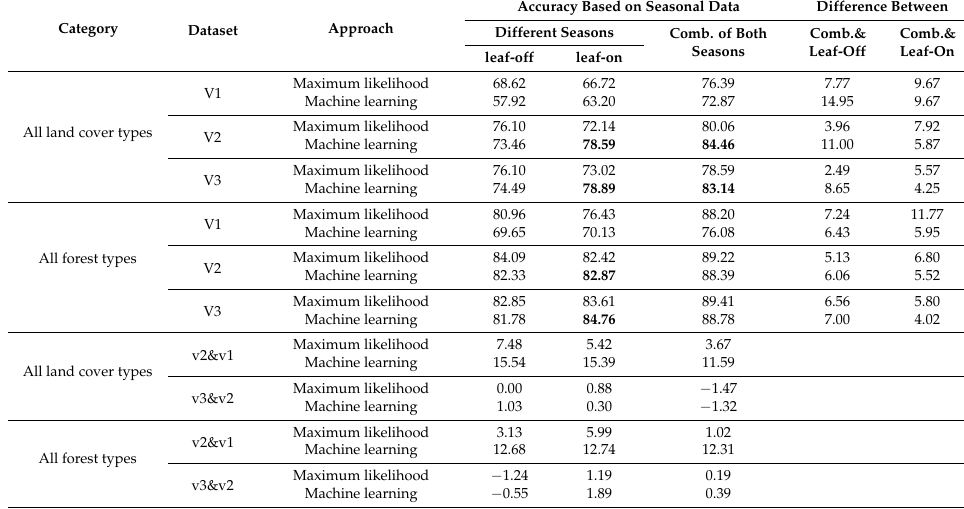
Note: The bold numbers in this table indicate the highest classification accuracies corresponding to different